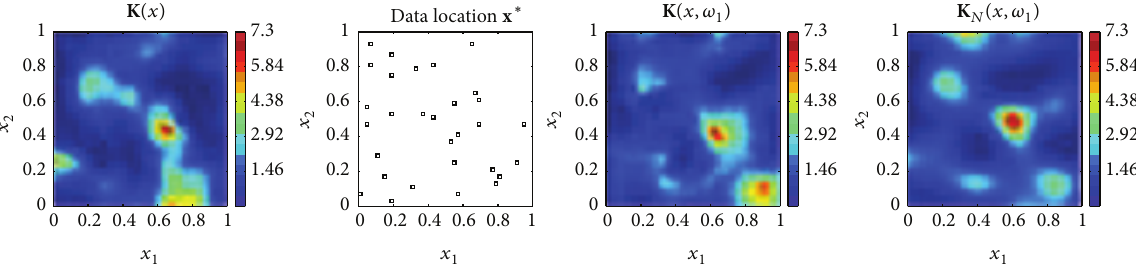
Figure 3: Far left: Permeability field used as the “true field” (and a source of data) for conditional simulations and the location of 𝑁 𝑚 = 30 points x ∗ (left). Right and far right: realizations of a conditional permeability field based on 𝑁 𝑚 = 30 data points: GSLIB (right) and KL expansion (far